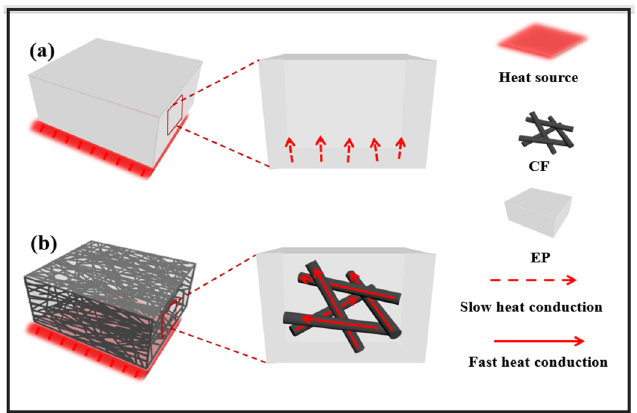
Figure 9. Schematic illustration of the heat conduction in the EP ( a ) and A-CF/EP/FEP ( b ) compo- sites.